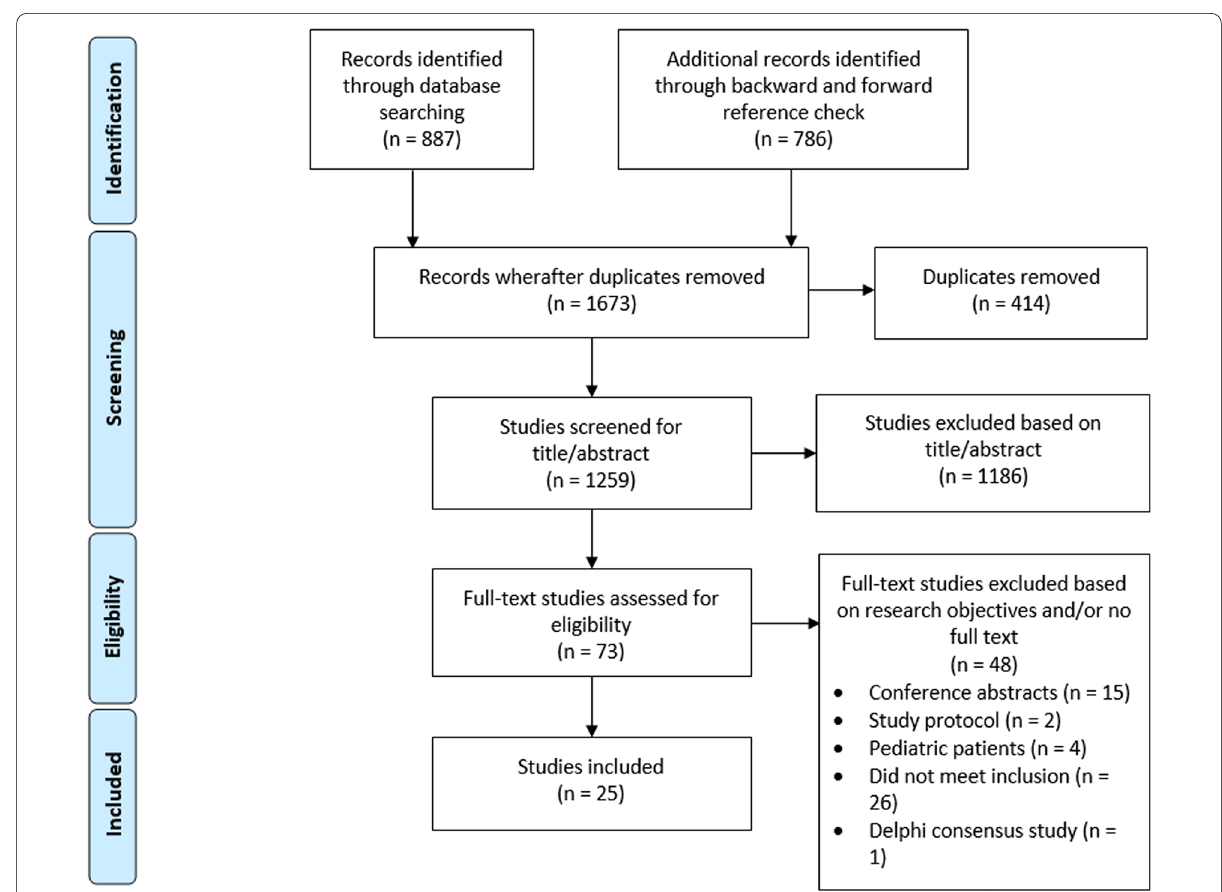
Fig. 1 PRISMA flow chart of literature search and review